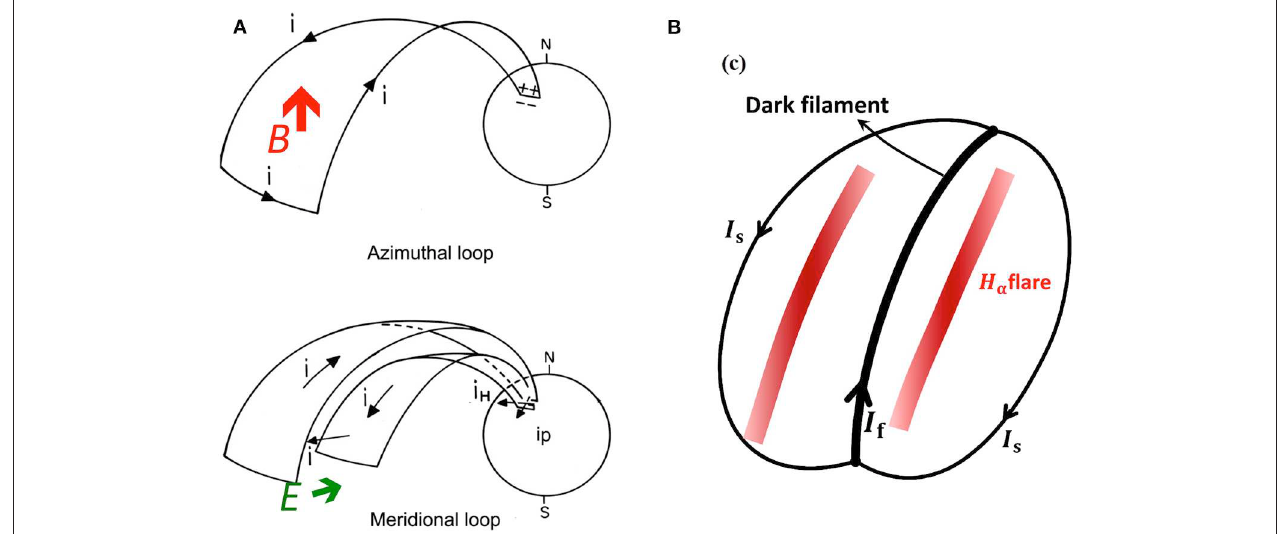
FIGURE 12 | The current system for the explosive phase. (A) The three-dimensional (3D) unloading (UL) current system, which consists of the azimuthal component and the meridional component (Bostrom, 1964). The earthward electric field E is responsible for establishing this current system. The magnetic field B produced by the azimuthal component advances its earthward end poleward, causing the poleward advance of auroral arcs and the auroral electrojet. Note that the so-called “dipolarization” cannot explain the poleward expansion; the stretched field lines go back to the pre-substorm location with the frozen-in particles. (B) The loop current system generated by the dynamo, which flows along the dark filament ( Akasofu and Lee, 2019). The loop current explodes during flares, which appears as a rising prominence above the solar disk.